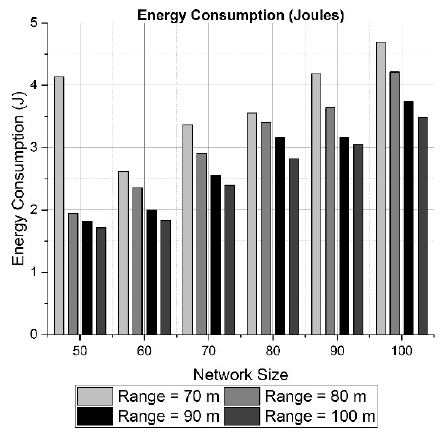
Figure 10. Total energy consumption in 50 Rounds (200 × 200 × 200 m).